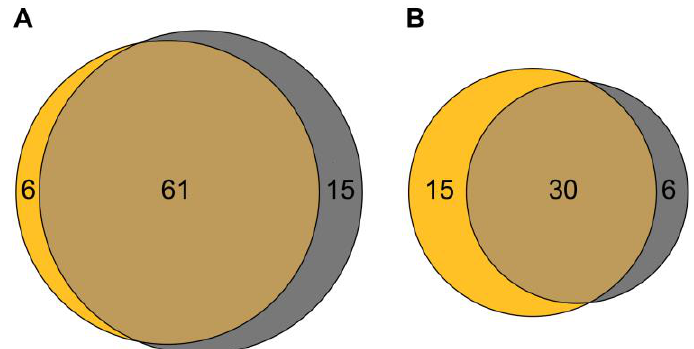
Figure 5. Venn diagram for the comparison of adult bees vs. brood comb honey for use as a matrix in the field. In total, 112 colonies were examined. Brood comb honey samples are visualized in yellow and the corresponding adult bee samples in grey. ( A ) Sixty-one colonies were diagnosed as P. larvae -positive using both matrices; 15 colonies and 6 colonies were identified as P. larvae -positive only when adult bees and brood comb honey were used as matrixes, respectively. ( B ) Thirty colonies were diagnosed as P. larvae -negative using both matrices; 6 colonies and 15 colonies were identified as P. larvae -negative only when adult bees and brood comb honey were used as matrixes, respectively. Data were visualized using the online tool: https://eulerr.co/ (accessed on 8 December 2022) [37,38].